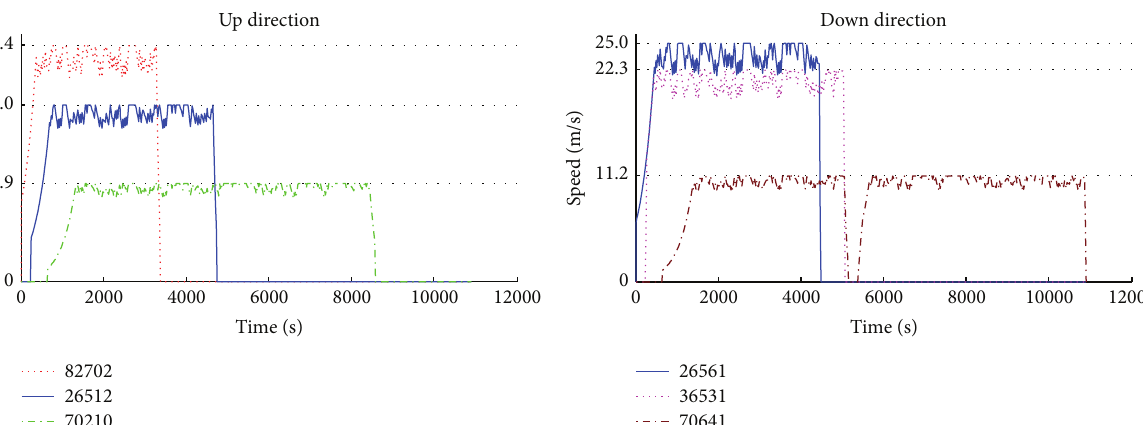
Figure 8: Train speed-time curve (the NCBS length is 15000 m).